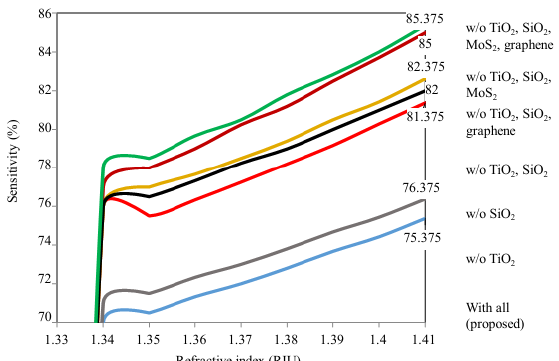
Fig. 6 Percentage of sensitivity vs. refractive index curve for different structures proposed.